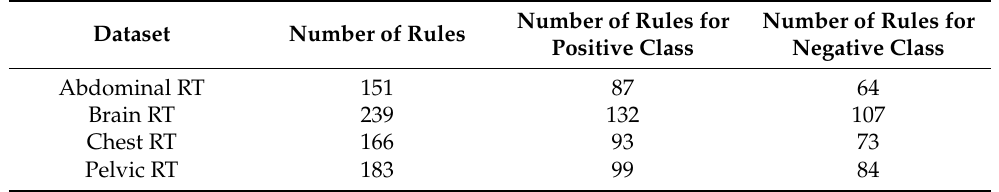
Table 3. Total number of rules and the number of rules with each category generated by the optimal DT classifier in the four datasets. Number of Rules for Number of Rules for Dataset Number of Rules Positive Class Negative Class Abdominal RT 151 87 64 Brain RT 239 132 107 Chest RT 166 93